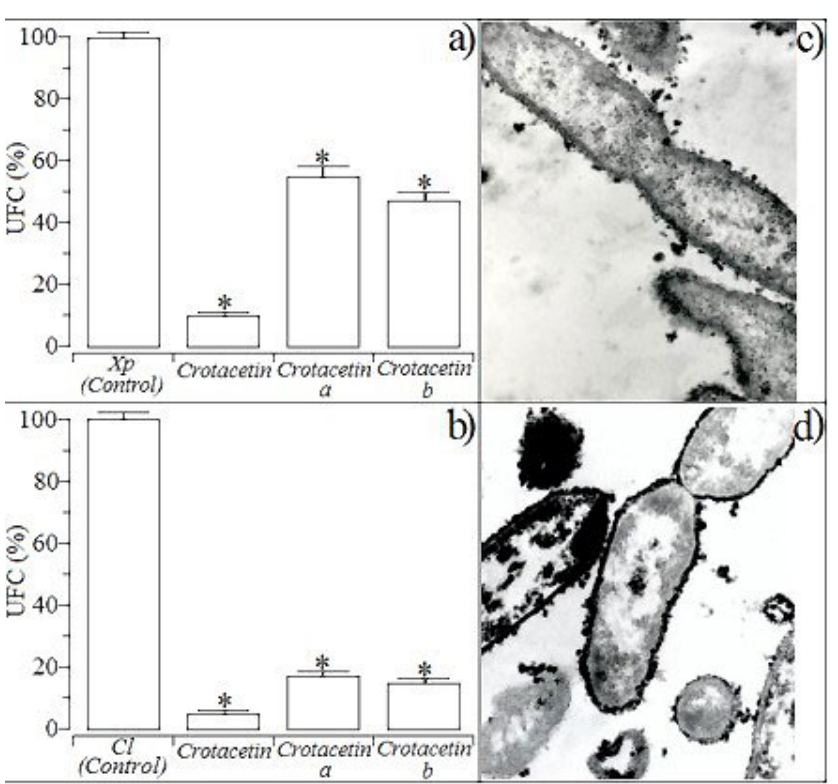
Figure 5: Antimicrobial activity of native crotacetin and isolated α and β subunits. A - Xanthomonas axonopodis pv passiflorae and B - Clavibacter michiganensis michiganensis were incubated with native crotacetin or with isolated α and β subunits. The reduction of anti-bacterial activity is compared. C - Transmission electron microscopy of untreated Xanthomonas axonopodis pv passiflorae and D - treated with crotacetin. Vacuolization of microbial cells is observed with crotacetin- treated